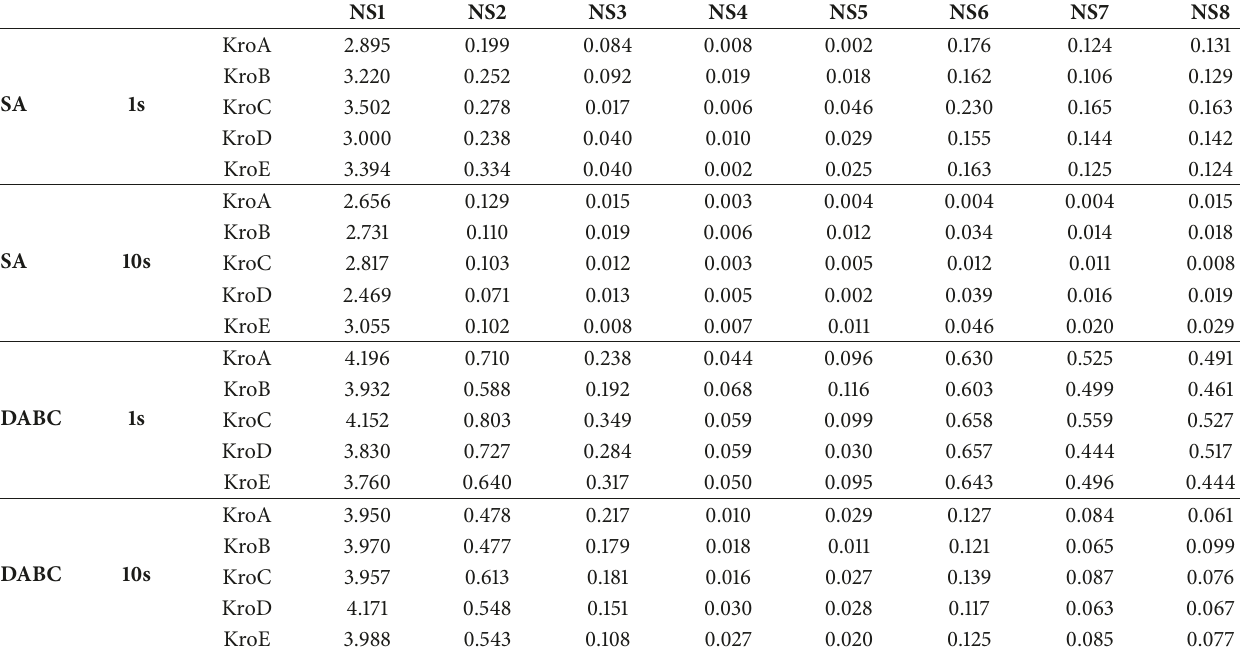
Table 2: Normalized results of SA and